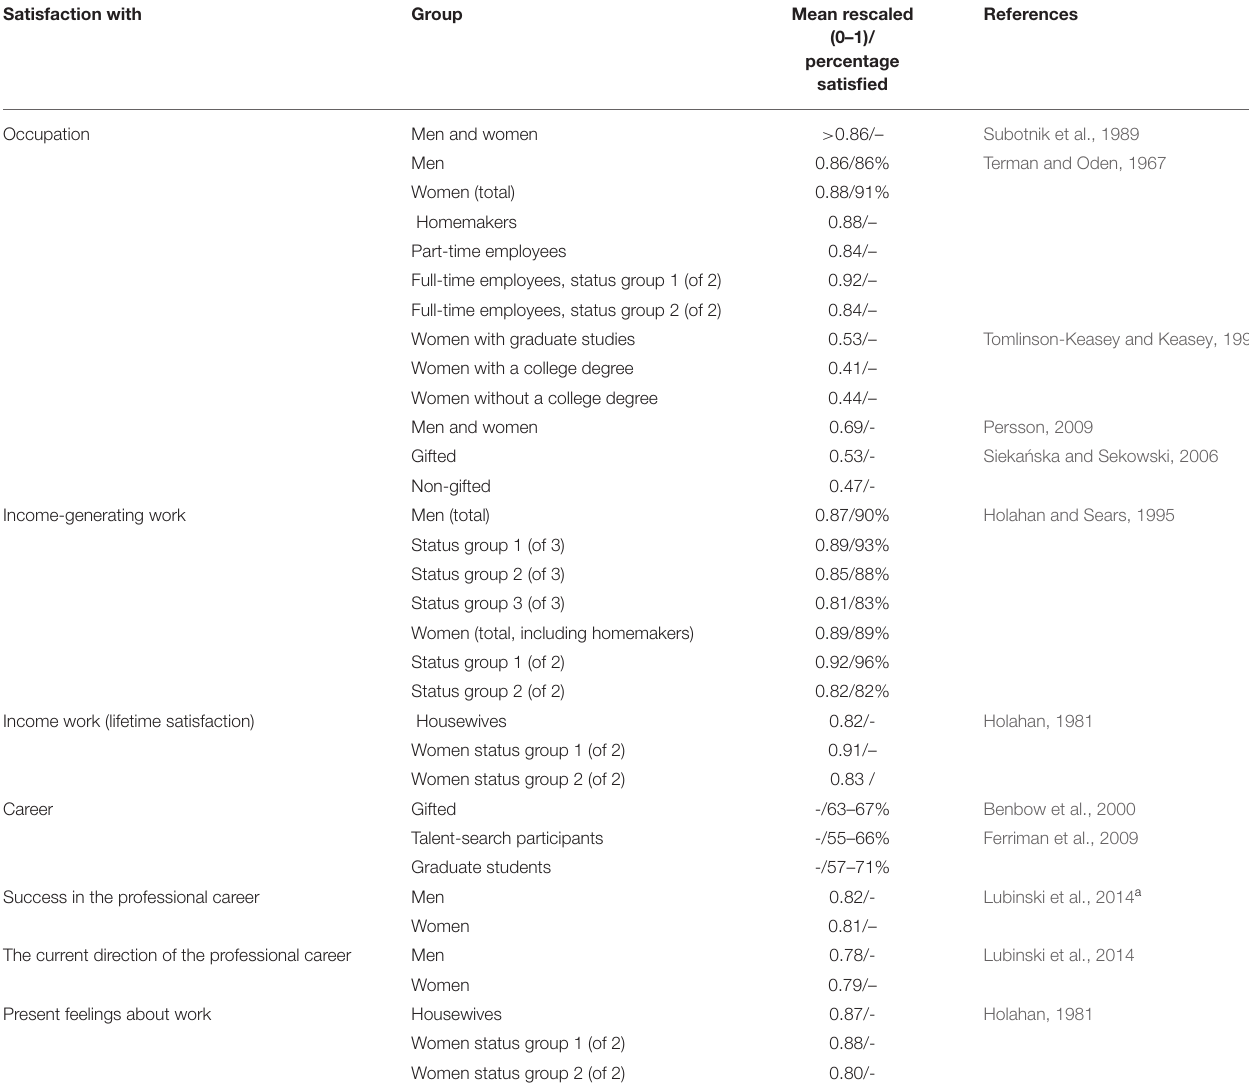
TABLE 8 | Job satisfaction by gender, occupational status, and giftedness. Satisfaction